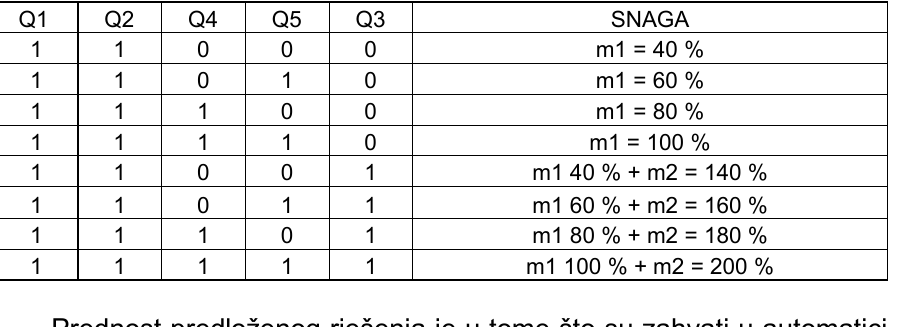
Table 1 – Combinations of the value of the output from the PLC to obtain the required engine